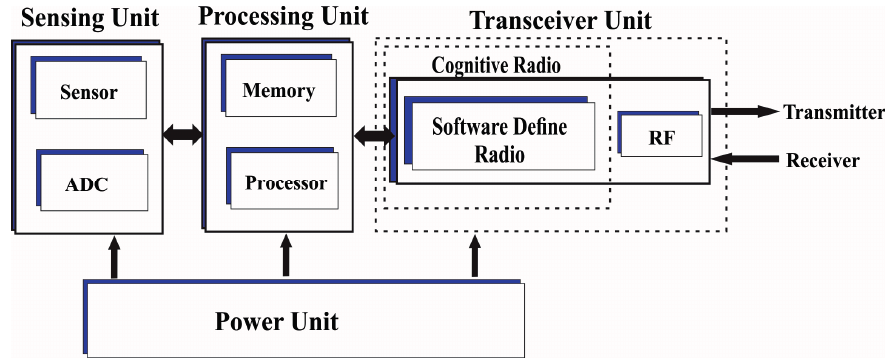
Figure 4. Block diagram of a cognitive radio sensor